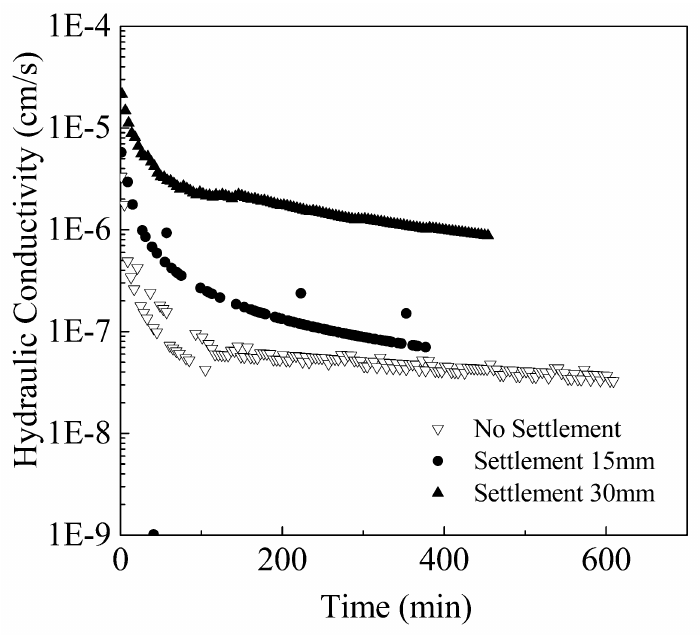
Figure 9. Time and hydraulic conductivity (soil thickness 200 mm; without geogrid).